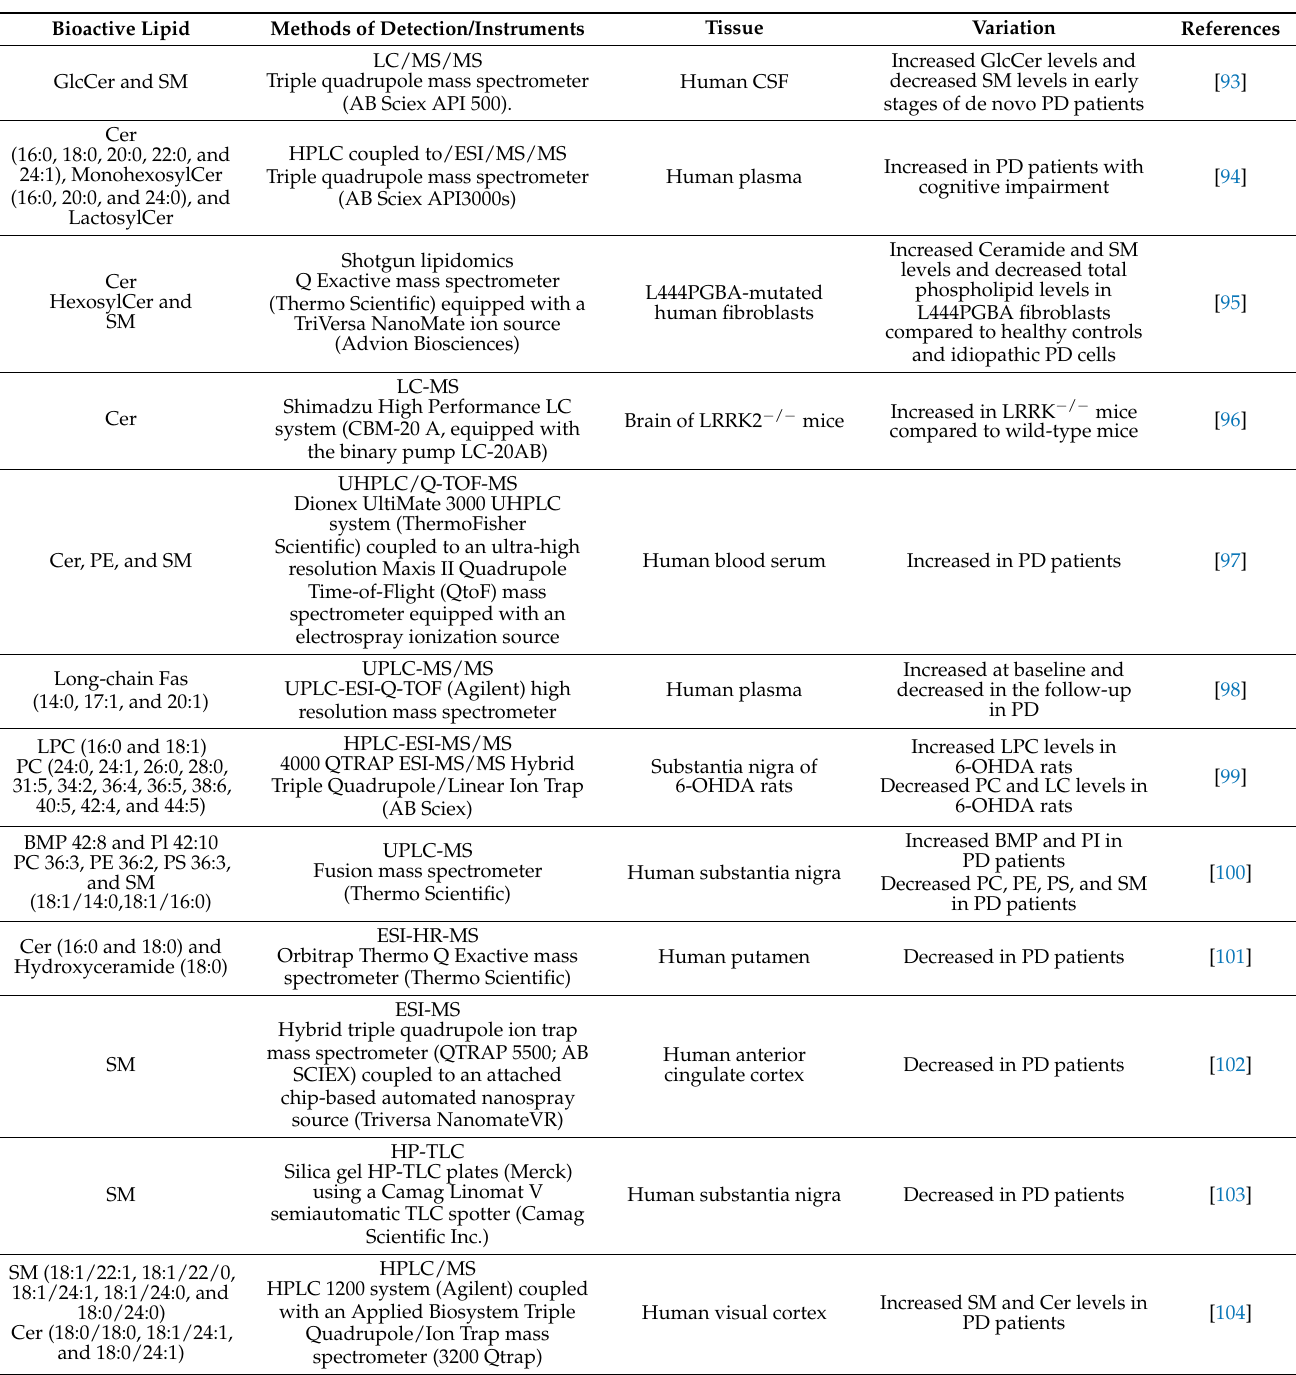
Table 2. Bioactive lipids evaluation in Parkinson’s disease by